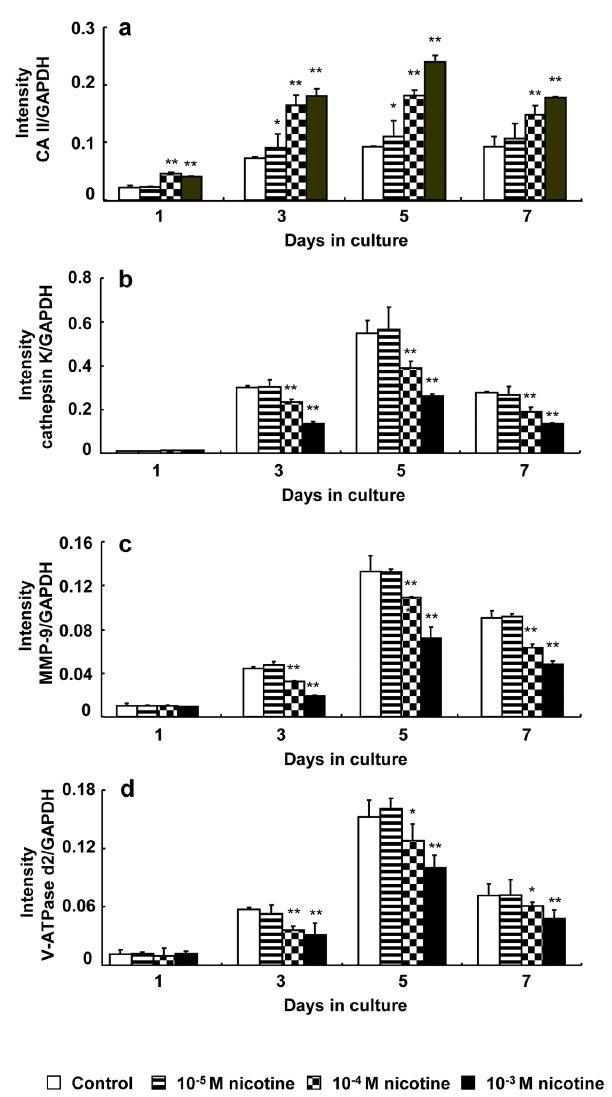
Figure 3. Effect of nicotine on mRNA expression of CA II, cathepsin K, MMP-9, and V-ATPase d2. RAW264.7 cells were cultured in differentiation medium with 0 (control), 10 2 5 , 10 2 4 , or 10 2 3 M nicotine for up to 7 days. The mRNA expression of CA II (a), cathepsin K (b), MMP-9 (c), and V-ATPase d2 (d) was determined using real-time PCR on days 1, 3, 5, and 7 of culture. Data are shown as the mean 6 S.D., n=3 independent experiments. *p , 0.05, **p , 0.01, nicotine treatment vs. control.